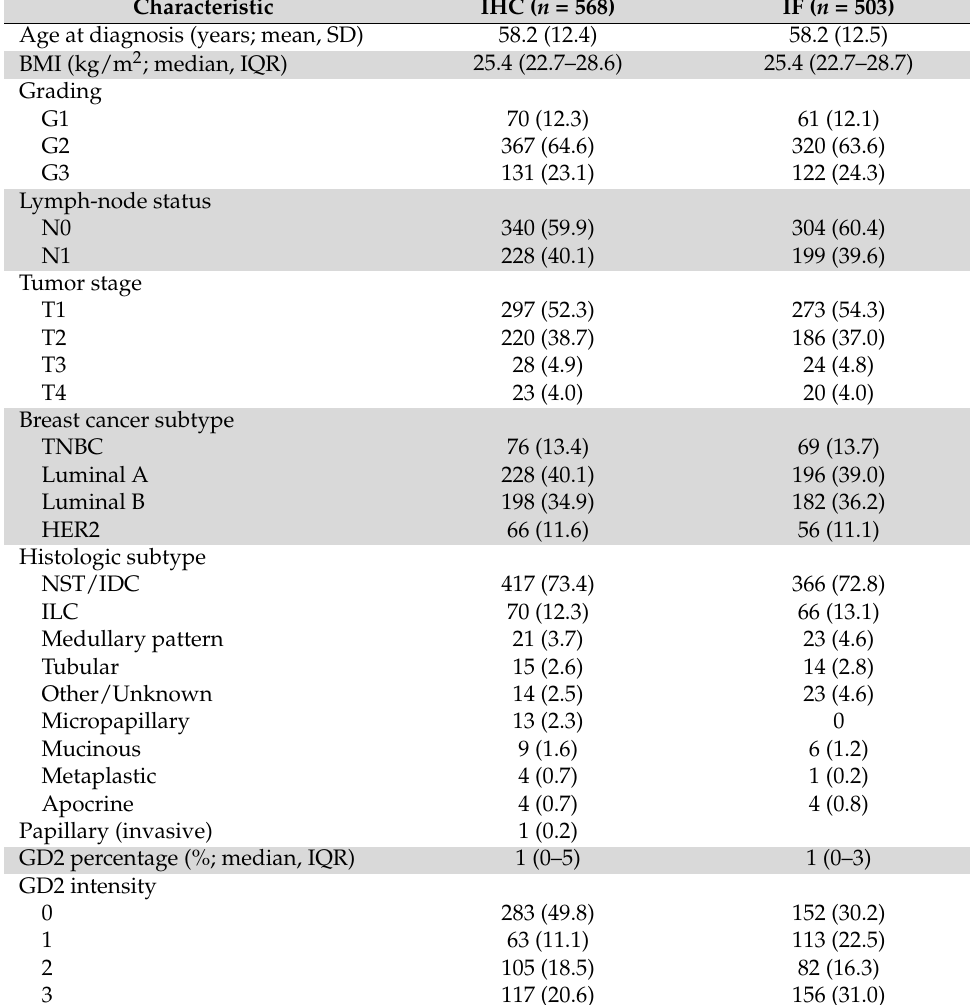
Table 1. Baseline characteristics of the study cohort with eligible GD2 values (based on immunohis- tochemistry and immunofluorescence) and results of GD2